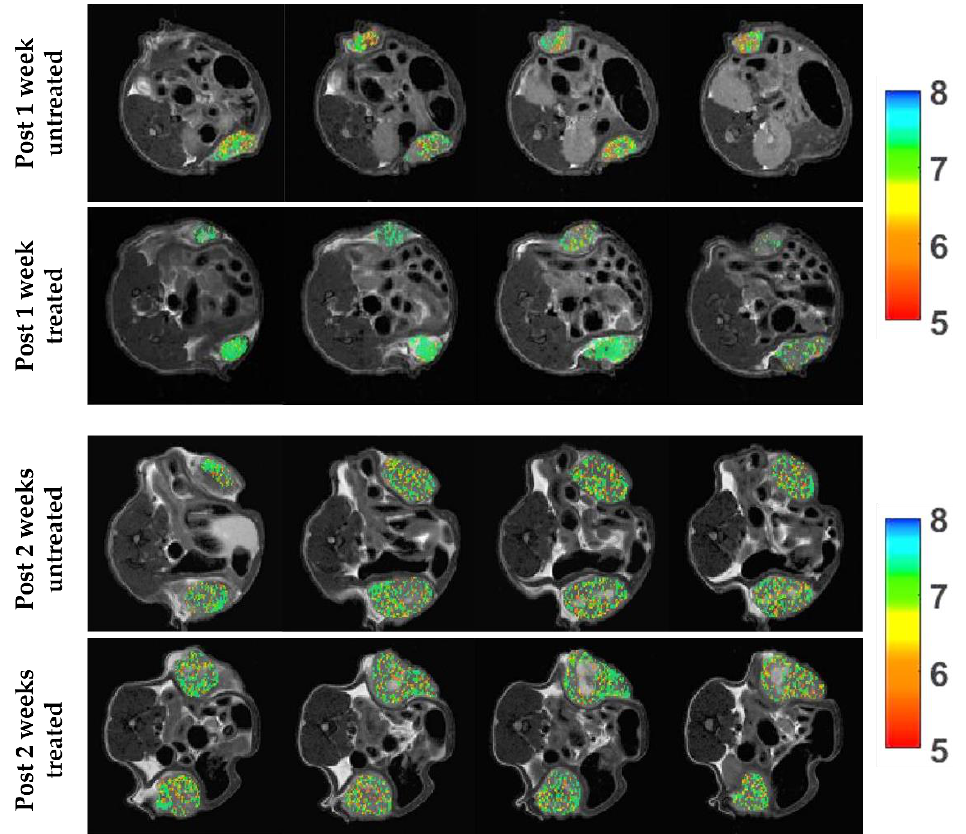
Figure 5. Extracellular tumor pH (pHe) images upon chronic Esomeprazole treatment. Representative tumor extracellular pH images (from top to bottom) after one week of treatment (average tumor pHe of 6.74/6.85 and of 6.98/7.05 for untreated and treated mice, respectively) and after two weeks of treatment (average tumor pHe of 6.90/6.94 and of 6.92/6.95 for untreated and treated mice,